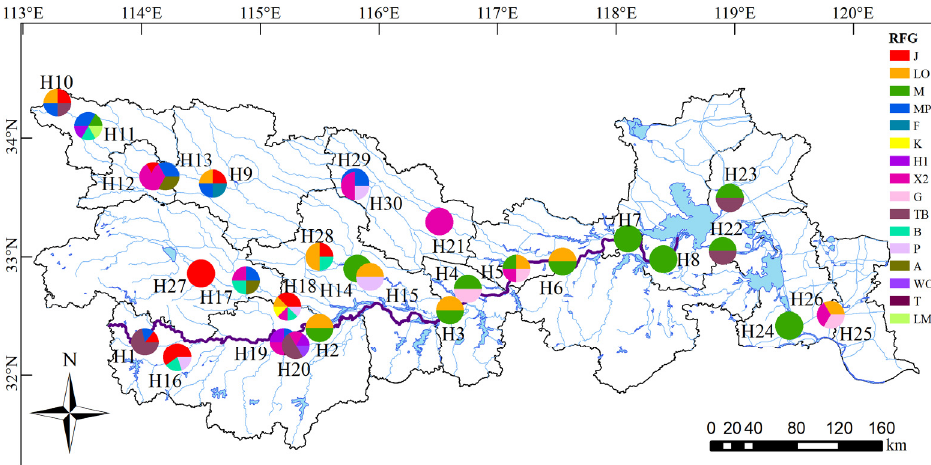
Figure 6. Distribution of phytoplankton functional groups in the Huaihe River Basin.